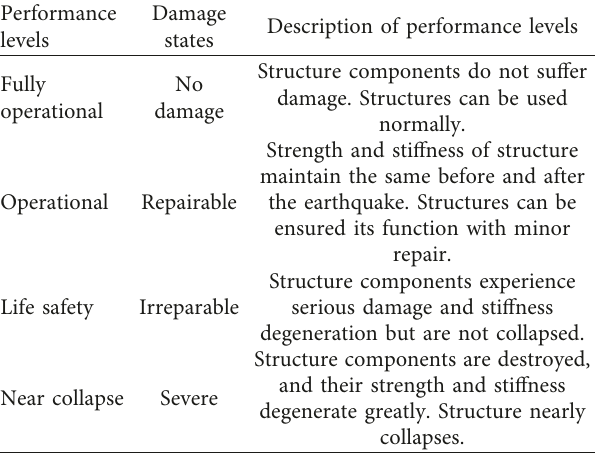
Table 1: Division of performance levels for large-space un- derground